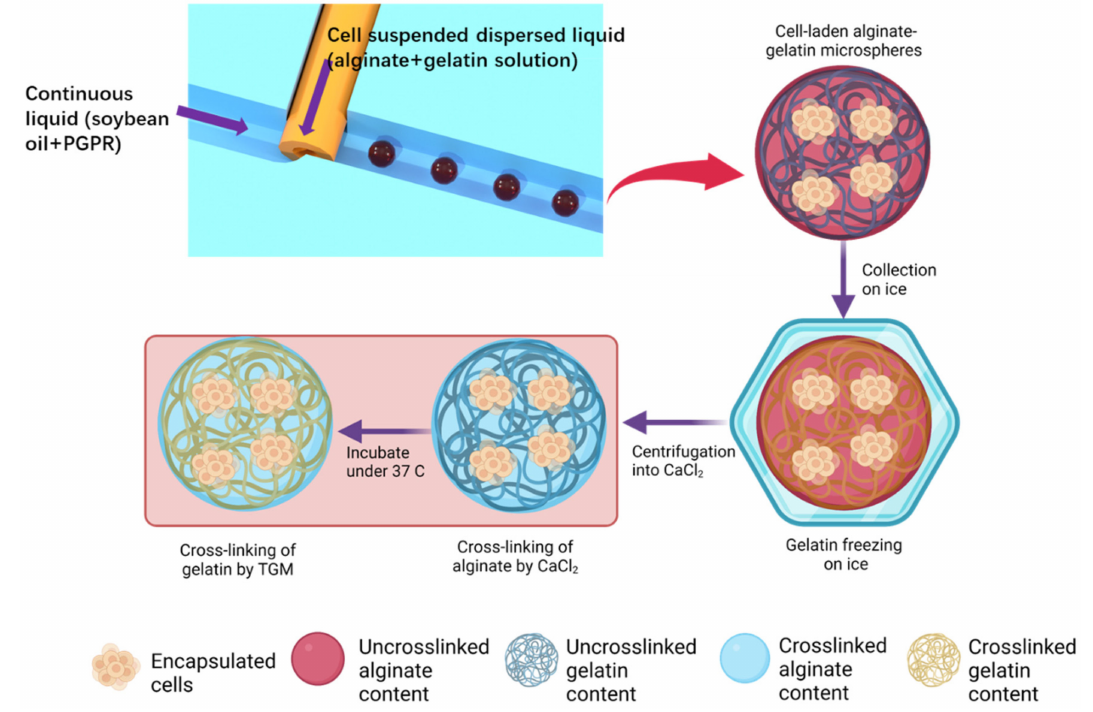
Figure 1. The schematic illustration of the microfluidic cell encapsulation system employing the novel step-T-junction microchannel with embedded microcapillary: the cell-laden alginate–gelatin microdroplets were collected on ice, allowing the freezing of the gelatin content under coldness; then, the alginate–gelatin microspheres were centrifuged from oil continuous liquid into cell culture medium containing CaCl 2 and cross-linking the alginate content of the microspheres; eventually tranglutaminase (TGM) was added to enable the secondary gelation of the gelatin